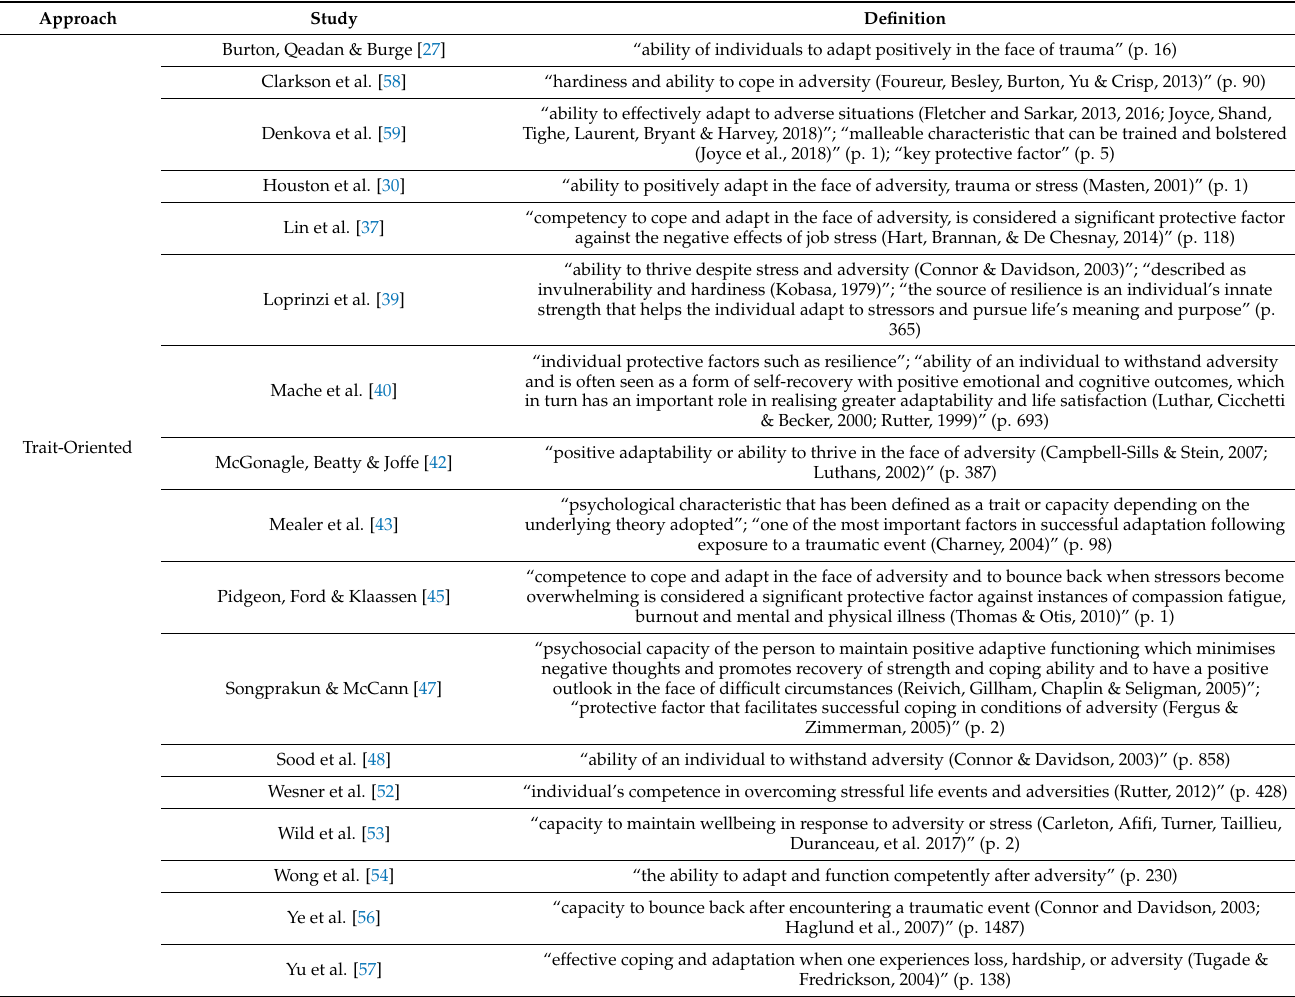
Table 2. Approaches and definitions of the resilience